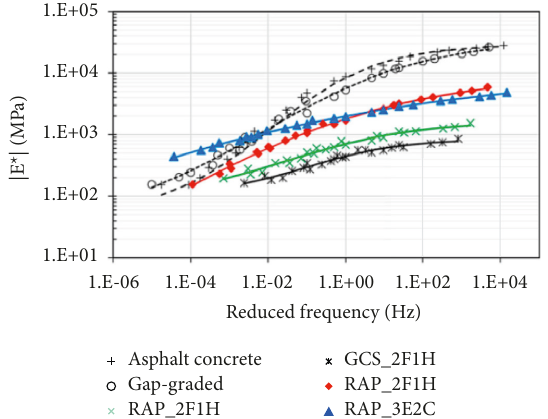
Figure 7: Mixtures’ dynamic modulus ( | E ∗ | ) master curve (source: Kuchiishi et al. [40]).